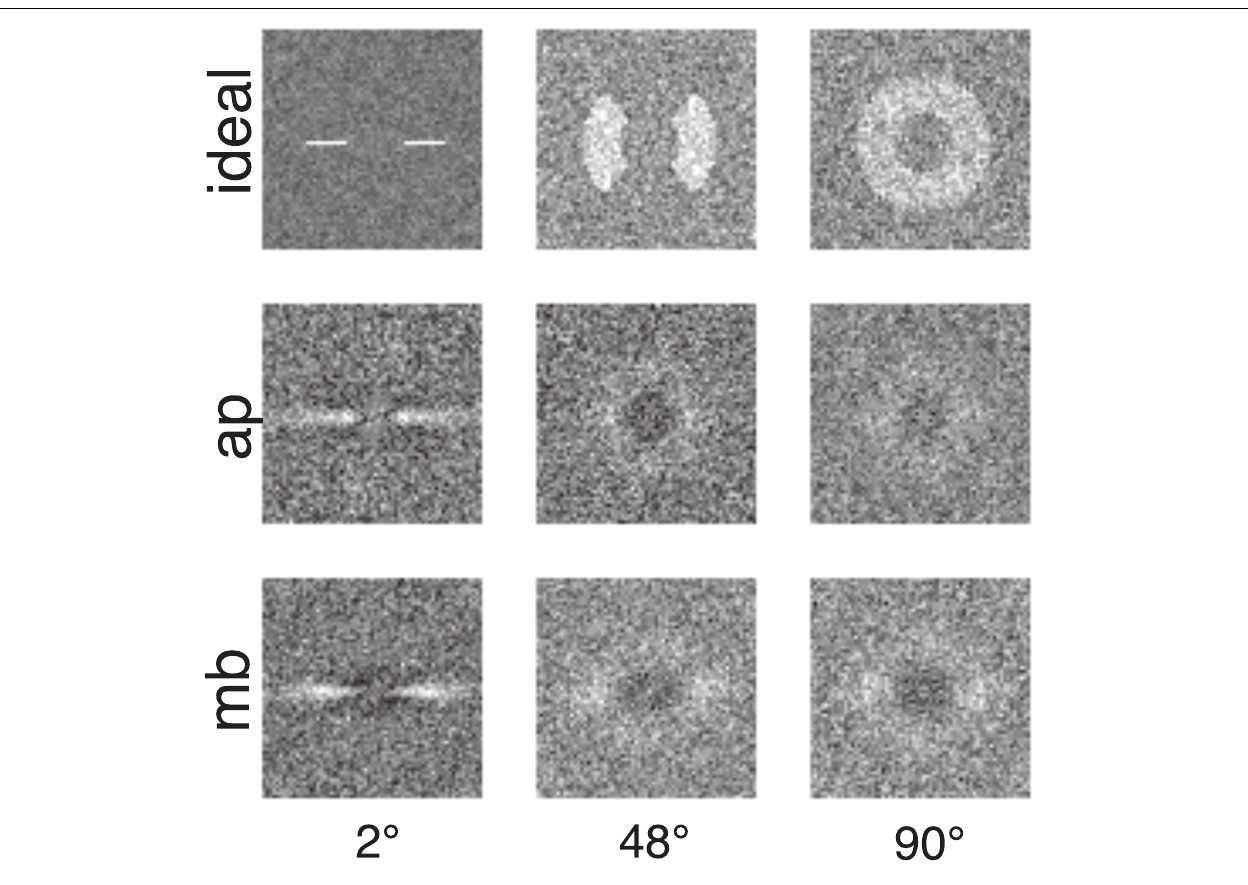
FIGURE 4 | Classification images for the ideal observer and two human observers. Low spatial frequencies are represented by the pixels in the center of the image and frequency increases with increasing distance from the center of the image. Horizontal orientations are represented in the center row of the image and